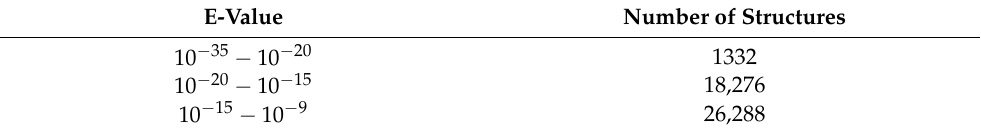
Table 1. Distribution of recognized protein motifs by E-value metrics